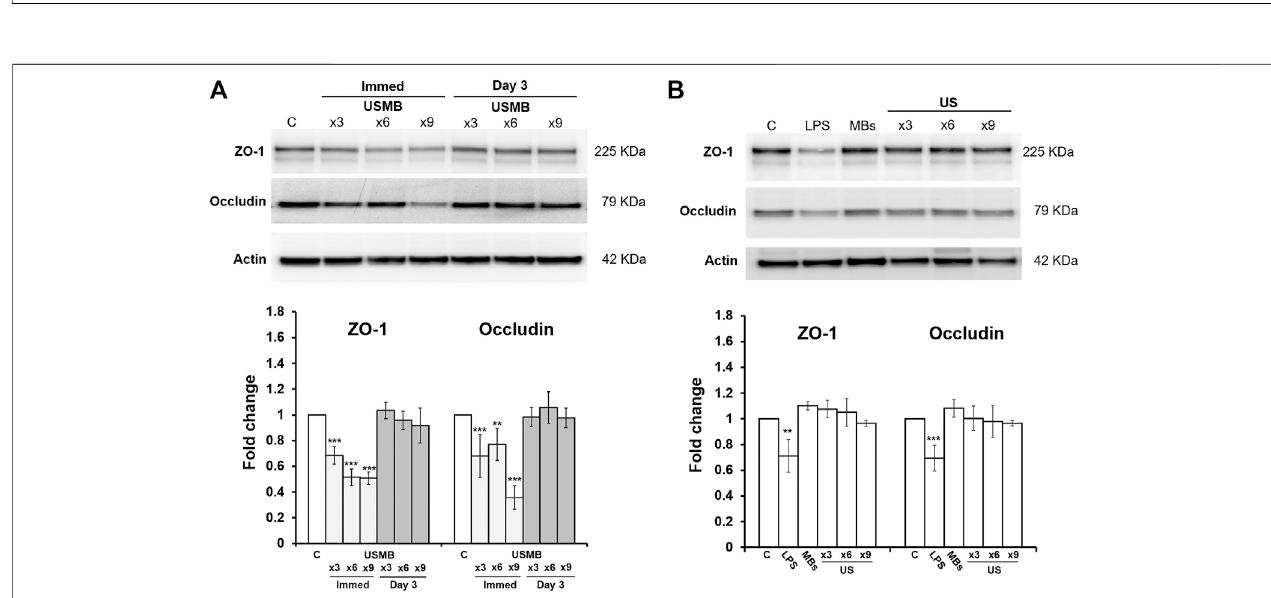
FIGURE 10 | Representative western blot analysis of ZO-1 and occludin protein levels of the RWM (upper panels) and digital quanti fi cation (lower panels) . UntreatedRWMservedasacontrolandLPS-treatedRWMservedasapositivecontrolforTJproteinreduction. (A) BothZO-1andoccludinproteinamountsintheRWM were signi fi cantly reduced immediately after various courses of USMB exposure, but the levels recovered 3 days later ( n (cid:2) 4 for each bar). (B) Both ZO-1 and occludin proteinamountsintheRWMrevealednosigni fi cantdifferenceinuntreatedRWM,RWMsoakedwithMBsbutwithoutUSexposure,orRWMgivenvariouscourses of US exposure but without MBs ( n (cid:2) 4 for each bar). The results are expressed as the mean ± standard error of the mean for the fold change in protein expression level relative to control. ** p < 0.01; *** p < 0.001; C, control; LPS, lipopolysaccharides; MBs, microbubbles; Immed, immediate; US, ultrasound; USMB, ultrasound